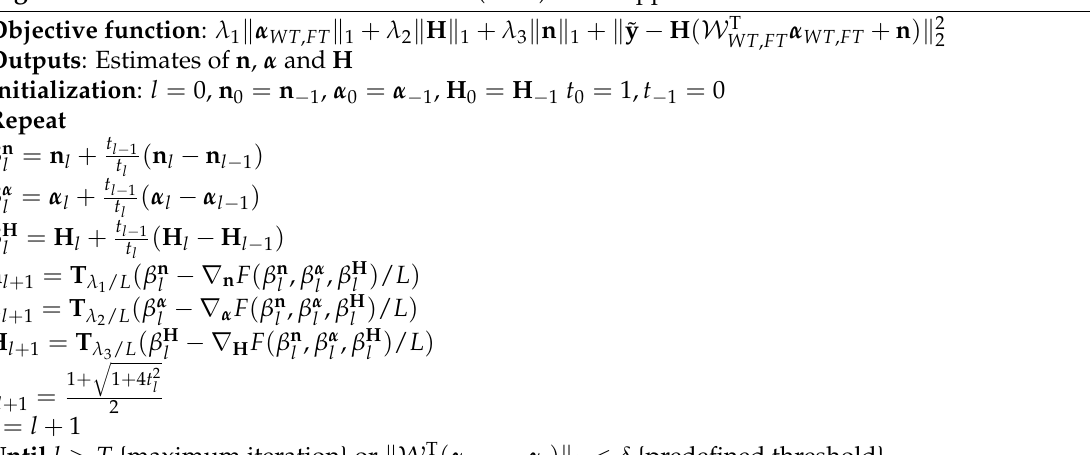
Algorithm 2 Accelerated Proximal Gradient (APG) based